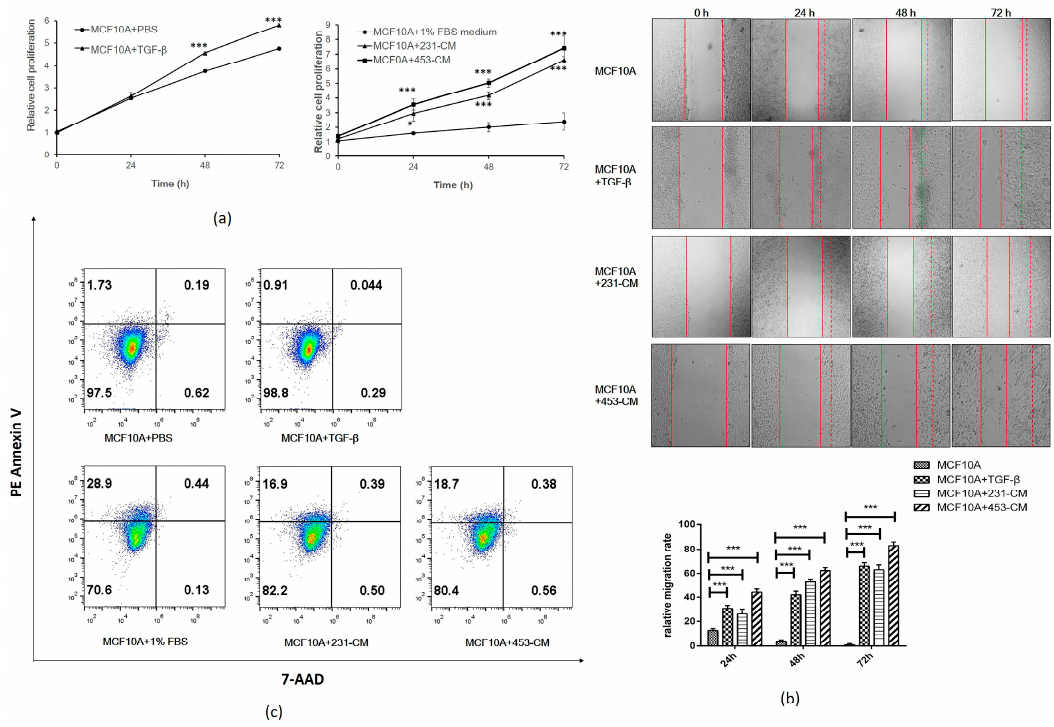
Figure 2. Proliferation and migration of TGF- β -treated and CM-treated MCF10A cells. ( a ) MTT assay of cell proliferation. Cells were seeded in 96-well plates and treated with 231-CM and 453-CM for 24, 48, or 72 h. DMEM/1% FBS-cultured cells were used as control. Proliferation was compared for TGF- β -treated vs. CM-treated cells. The results shown are mean ± standard error of measurement (SEM) from three independent experiments. * p < 0.05 ,*** p < 0.001; ( b ) Wound assay of cell migration. The cells were cultured in 24-well plates to high confluence (>80%), scratched with a 200- μ L pipette tip at the marked position, washed twice with PBS, cultured in fresh medium with 1% FBS, and treated with TGF- β or 231-CM or 453-CM for 24, 48, or 72 h. Nontreated cells were used as control. Wounds were photographed at the marked position at the above times under phase-contrast microscopy (10 ×